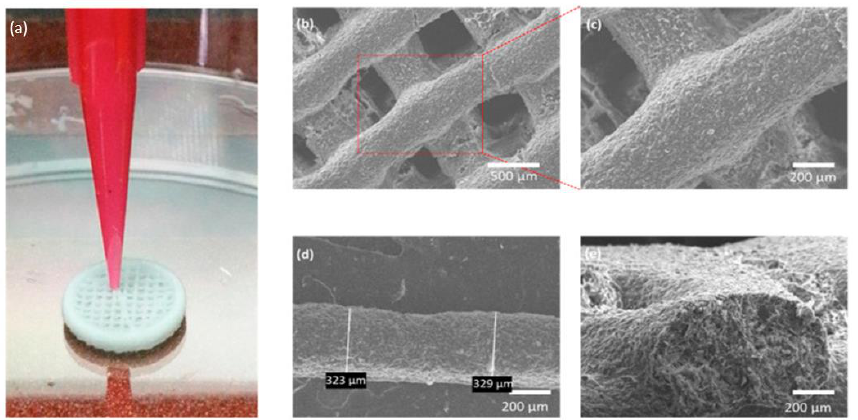
Figure 10. ( a ) Illustration of 3D printed scaffold of tripeptide–alginate–cellulose bioink; ( b – e ) SEM images: ( b ) top view; ( c ) higher magnification of the area marched in ( b ); ( d ) single mat filament ( e ) cross-section of the filament [35].